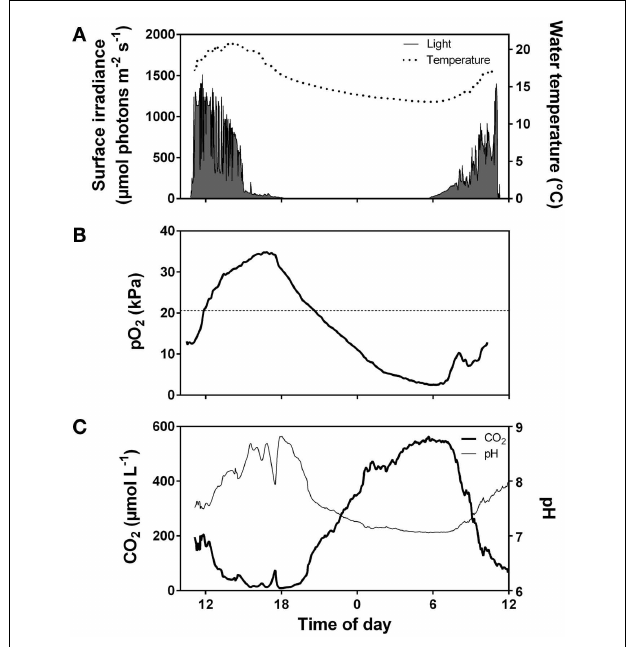
FIGURE 3 | Diurnal fluctuations in surface irradiance and water temperature (A), O 2 partial pressure (B), and CO 2 concentration and pH (C) in the water of a vegetation rich pond inWesternAustralia .The pond was densely vegetated by Meionectes brownii which in late afternoon had extracted CO 2 from the water down to below air equilibrium ( < 15 µ mol L − 1 ). During the night, total system respiration consumed O 2 (pO 2 dropped to 2.5kPa early in the morning) and CO 2 rose to 550 µ mol L − 1 . Data extracted from Rich et al.